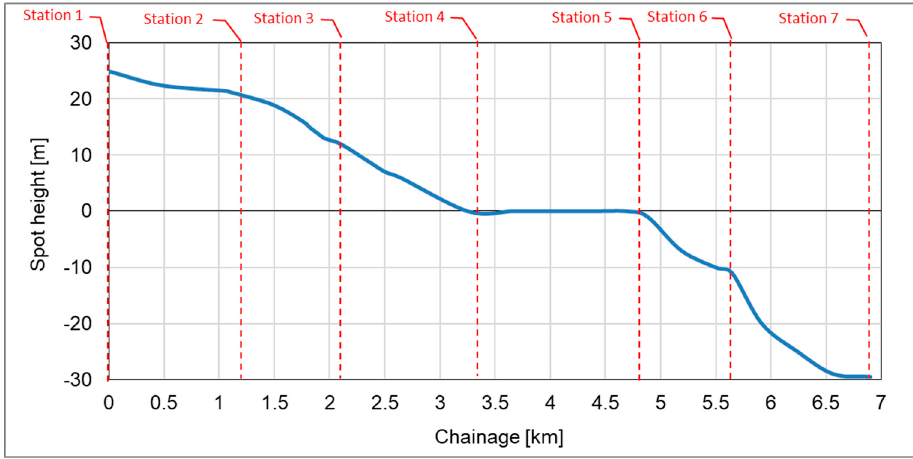
Figure 3. Route details.